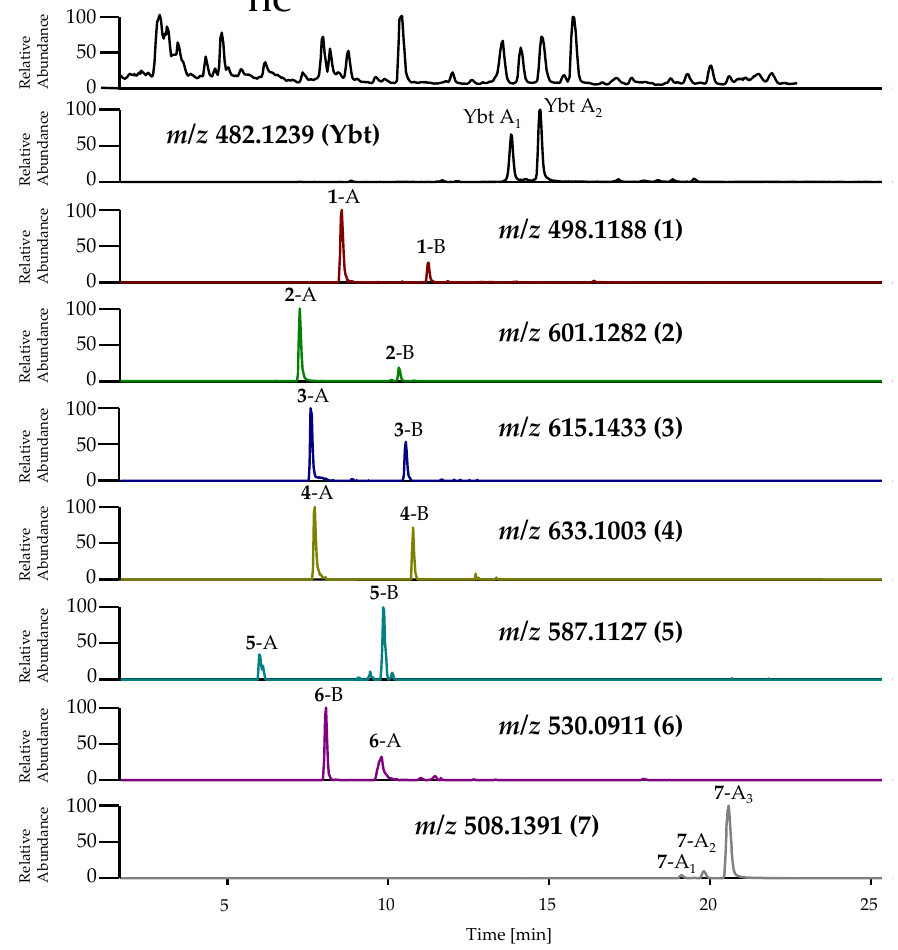
Figure 9. TIC and EIC of Ybt and its novel derivatives in the pre-concentrated supernatant of cultures of EcN from the isolation of ulbactin B. Analysis was carried out by LC-HRMS. The abbreviations for these metabolites are summarized in Table S3 in the Supplementary Material. Ybt ([M + H] + : C 21 H 28 N 3 O 4 S 3 +